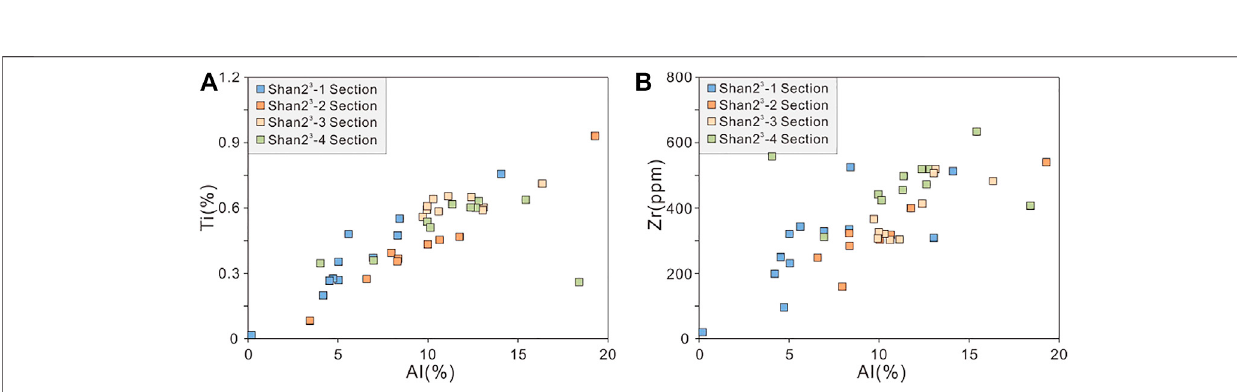
Frontiers in Earth Science |